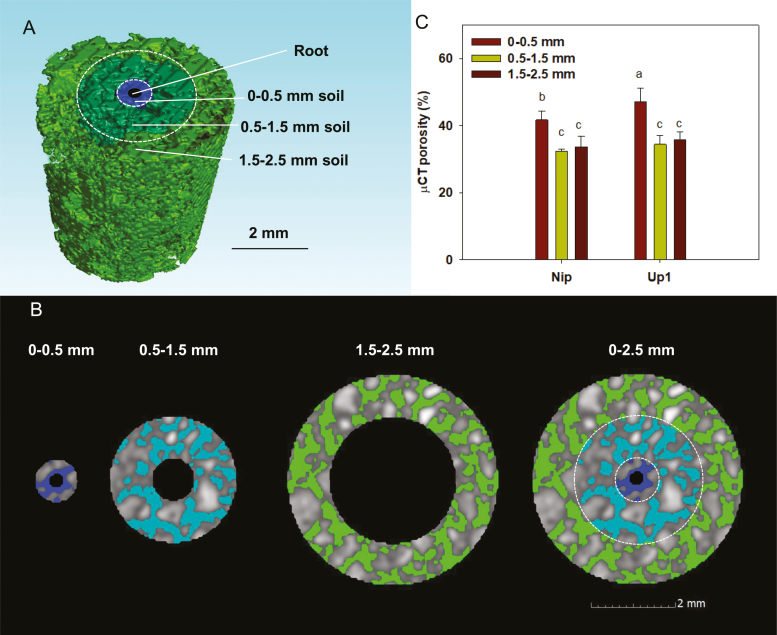
Porosity of the rhizosheath (0–0.5 mm radius concentric circle) and other soil (0.5–1.5 mm radius and 1.5–2.5 mm radius concentric circles) of two rice varieties (Nip and Up1) under the MWS condition. (A) Three-dimensional soil pores around the root. The 0.5 mm radius concentric circle around the root clearly established the rhizosheath; thus, the 0.5 mm radius concentric circle was defined as the rhizosheath. Soil pores in the 0.5–1.5 and 1.5–2.5 mm radius concentric circles were also analysed. (B) Division of each cylinder into three concentric rings around the root. Extracted root: hole in the middle of the 0–0.5 mm radius concentric circle; soil: grey; pores: blue and green. (C) Porosity of the rhizosheath (0–0.5 mm) and other soil (0.5–1.5 and 1.5–2.5 mm). Bars with different letters were significantly different at P<0.05.